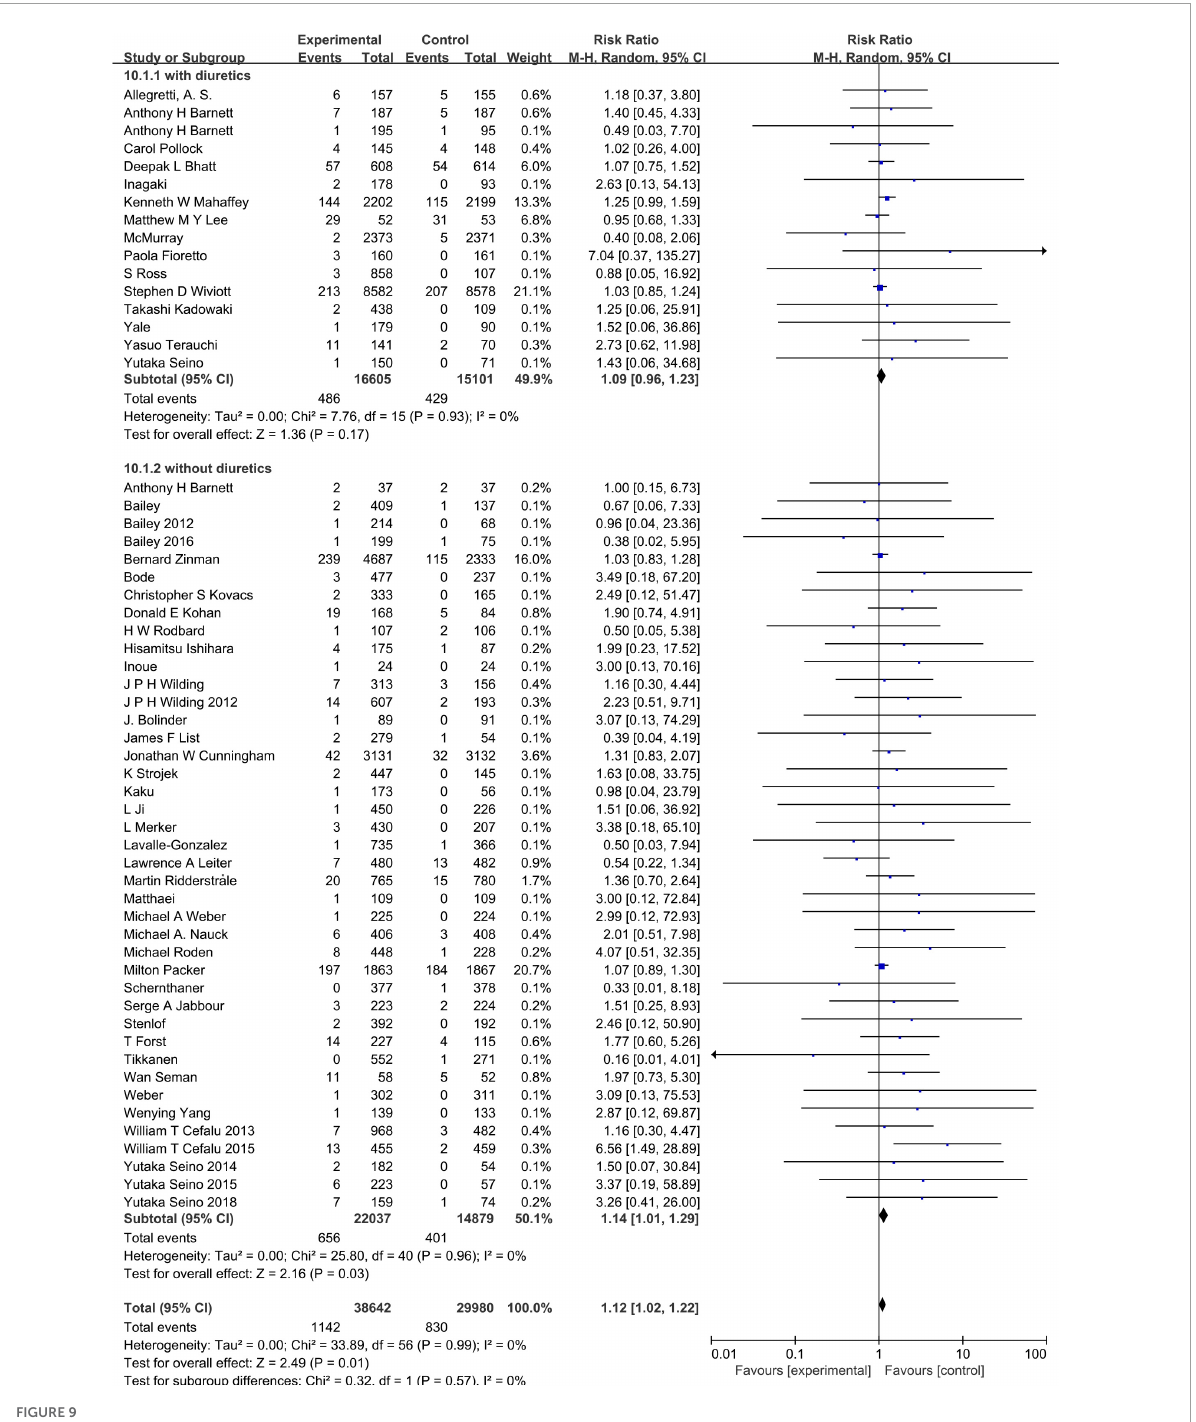
FIGURE9 Subgroup analysis of the hypovolemia events between the SGLT2 inhibitors group vs. the placebo group stratified by diuretics